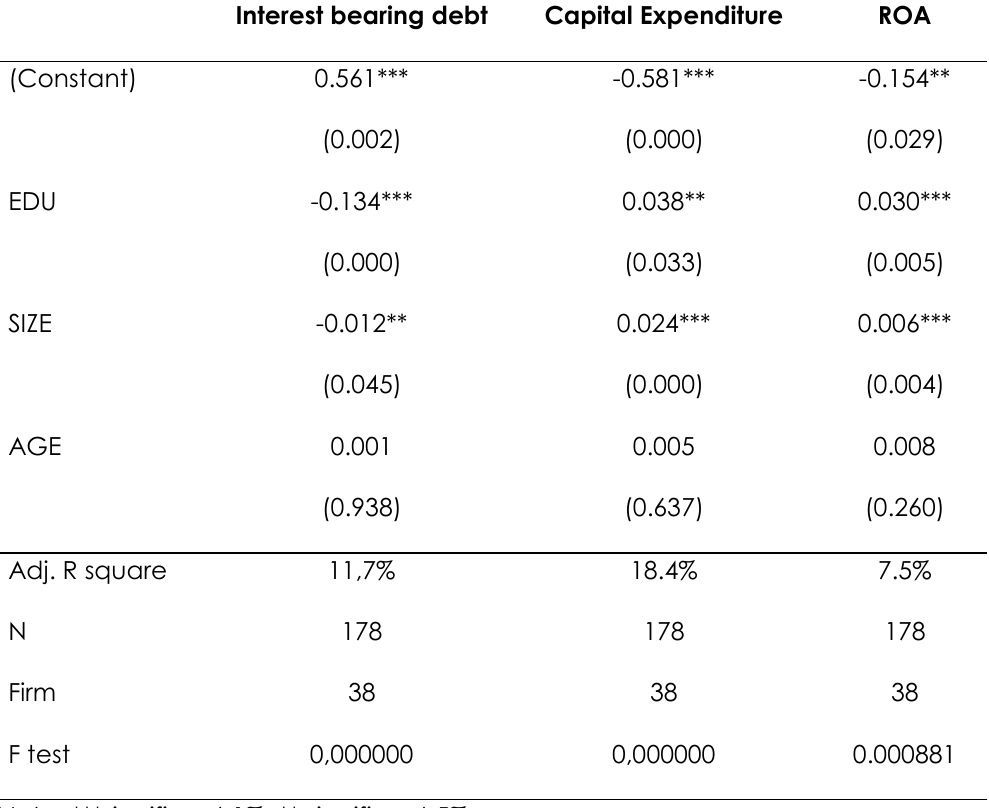
Table 2. Regression Results Interest bearing